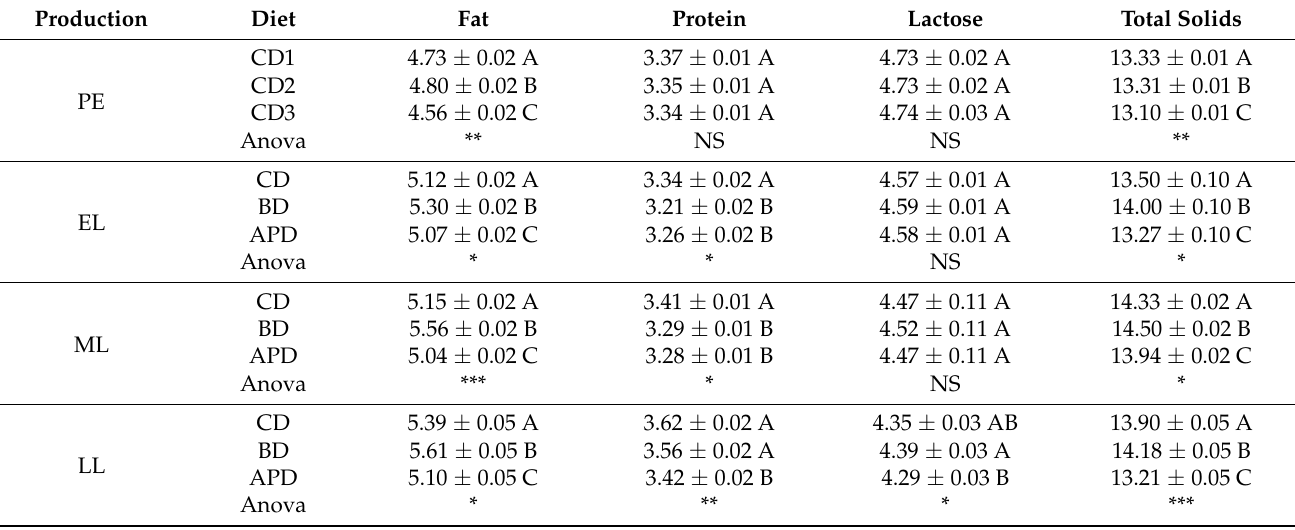
Table 1. Principal components (fat, protein, lactose and total solids) content (g/100 mL) in raw milk used for the different productions of fermented